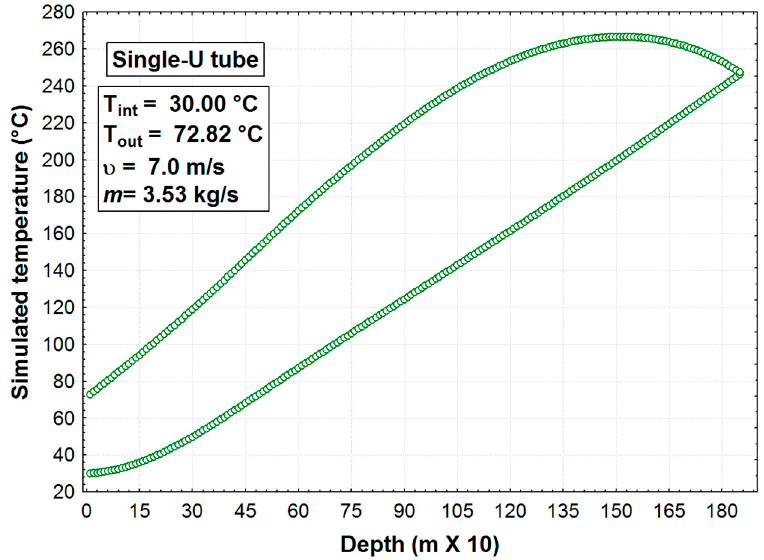
Figure 9. Temperature simulated along the U-tube heat exchanger in well W-LV5. T out corresponds to the temperature of water to the heat exchanger outlet , υ to fluid velocity, and m to mass flow.